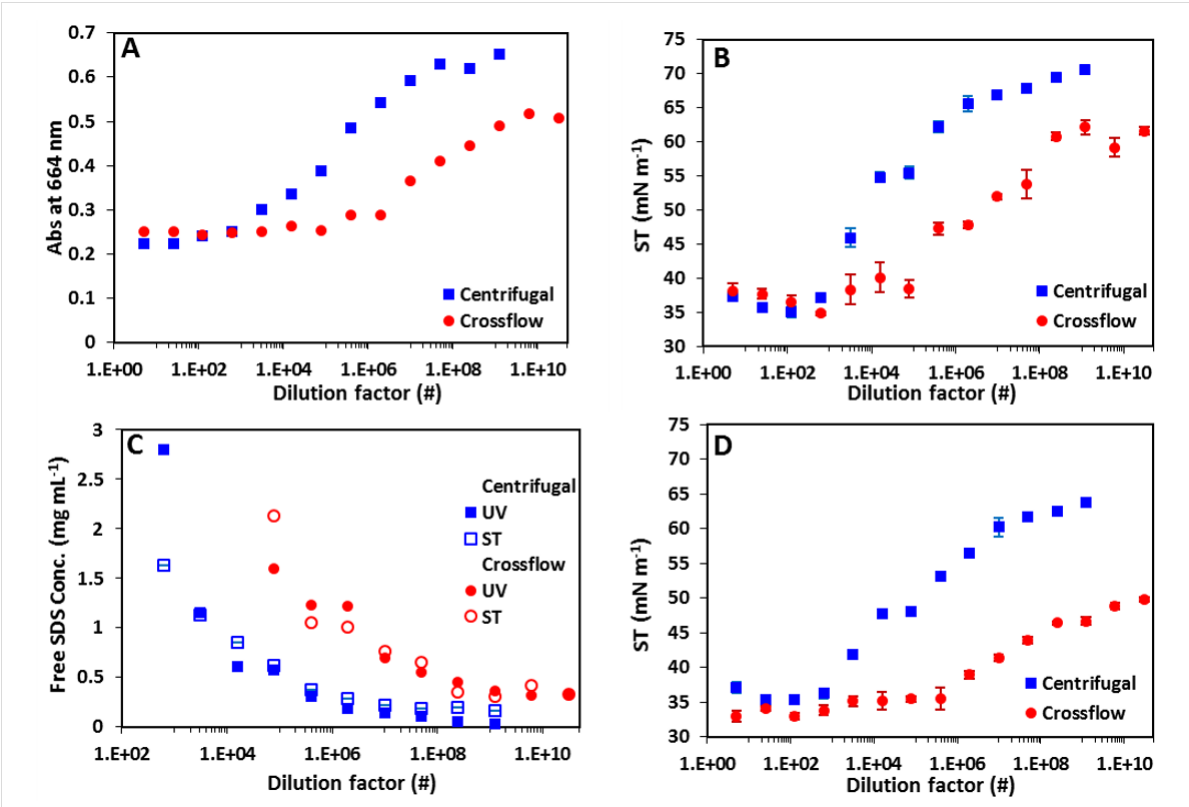
Figure 2: The absorbance at 664 nm of the filtrates of P3HT:ICxA NP inks (A), and surface tension (ST) (B) of the filtrates of P3HT:ICxA NP inks with different dilution factors for centrifugal (blue squares) and crossflow (red circles) ultrafiltration processes. (C) Free SDS concentrations in filtrates vs dilution factor for centrifugal (squares) and crossflow (circles) ultrafiltration processes. (D) The surface tension of NP inks with varying dilution factor for centrifugal (squares) and crossflow (circles) ultrafiltration